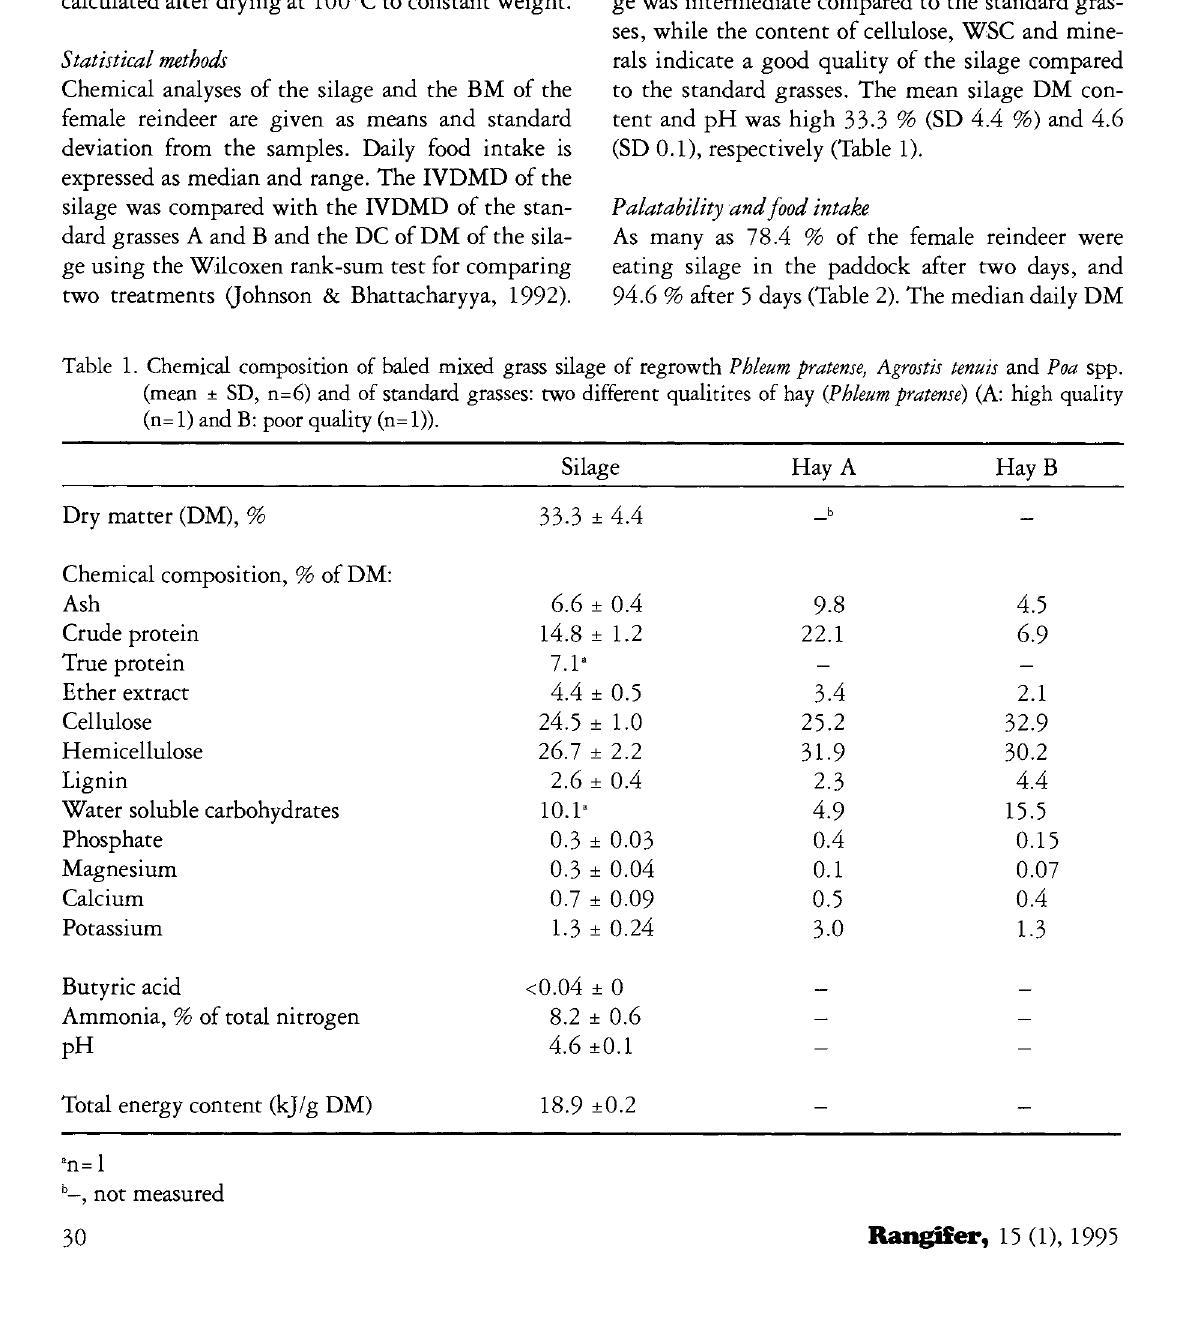
Table 1. Chemical composition of baled mixed grass silage of regrowth Phleum pratense, Agrostis tenuis and Poa spp. (mean ± SD, n=6) and of standard grasses: two different qualitites of hay {Phleum pratense) (A: high quality (n = 1) and B: poor quality (n=